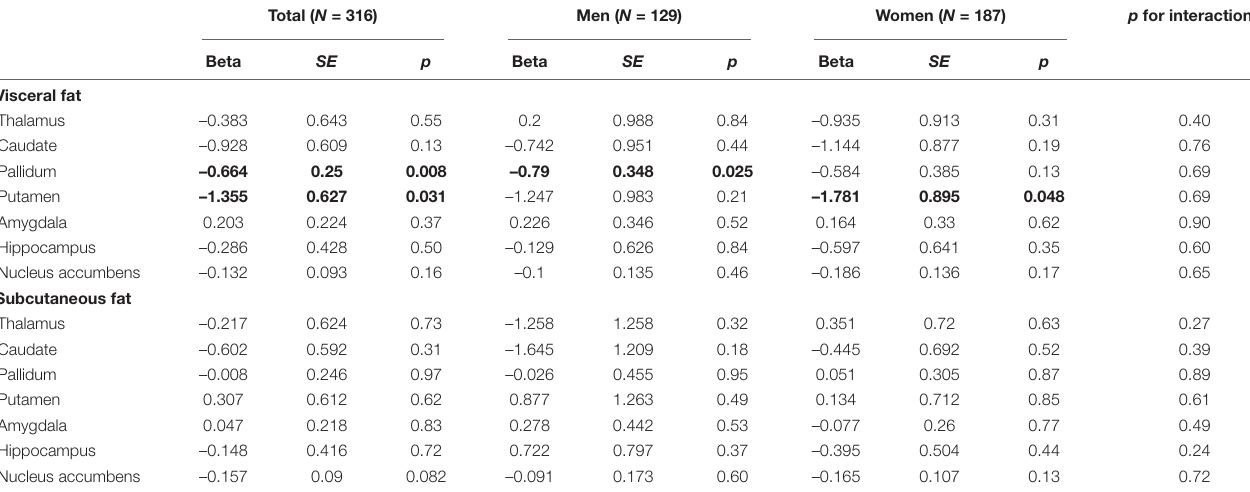
TABLE 4 | Association between abdominal fat area and subcortical